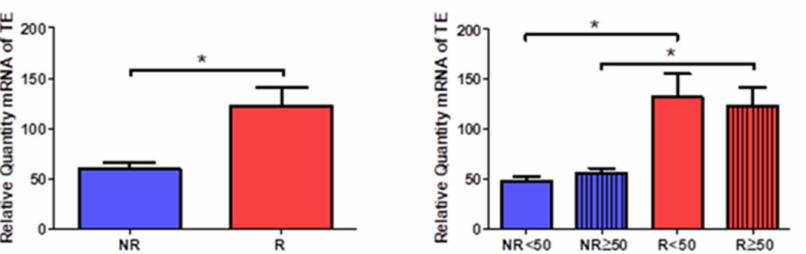
Figure 6. Levels of mRNA of the gene for tropoelastin quantified by RT-qPCR of patients without reflux (NR) and with reflux (R), as well as by their ages. * p < 0.05. Protein expression by immunohistochemical techniques of tropoelastin revealed that the largest number of patients with positive immunodetection were in the venous reflux group: 91.34% compared to 65.52% of the NR patients. Taking into account the age factor, we observed how patients R < 50 had the highest percentage of expression (NR < 50 = 61.54%, NR > 50 = 68.75%, R < 50 = 93.75%, R > 50 =